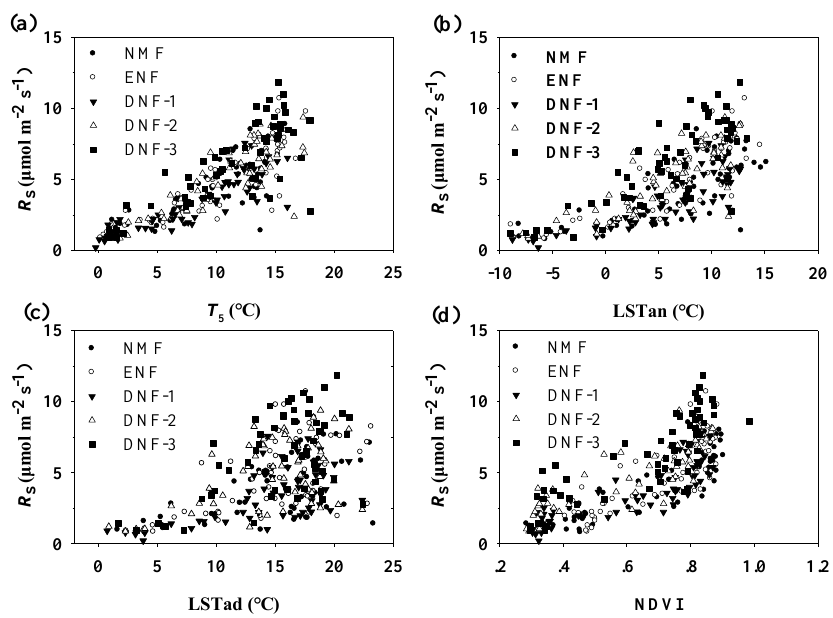
Figure 2. Correlations between soil respiration ( R s , μmol CO 2 m −2 s −1 ) and ( a ) soil temperature at the 5 cm depth ( T 5 , °C), ( b ) nighttime land surface temperature from Aqua MODIS (LST an , °C), ( c ) daytime land surface temperature from Aqua MODIS (LST ad , °C), and ( d ) normalized difference vegetation index (NDVI) during the measurement. Table 6. Results of statistical analysis relating soil respiration to VIs at the five sites for all measured data during measurement